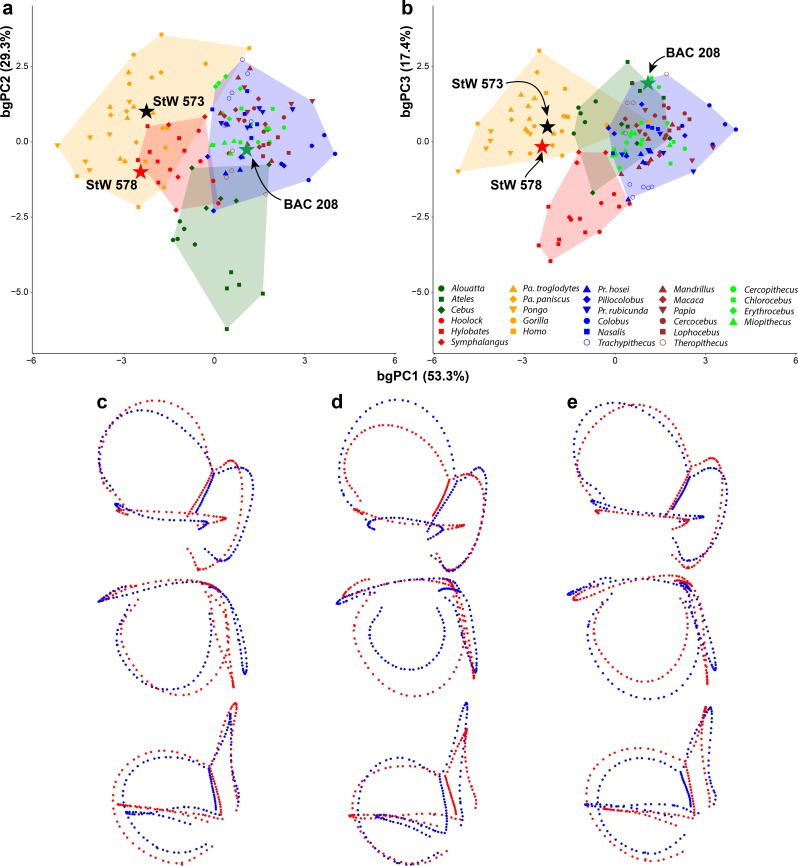
Main patterns of vestibular shape variation among the analyzed anthropoid sample as shown by bivariate plots of principal components from the landmark-based between-group principal components analysis (bgPCA) using major taxa as in Figure 2.(a) bgPC2 vs. bgPC1. (b) bgPC3 vs. bgPC1. Variance explained by each bgPC is included within parentheses. Lateral (top), superior (middle), and anterior (bottom) views of landmarks and semilandmark maximum (red) and minimum (blue) conformations for (c) bgPC1, (d) bgPC2, and (e) bgPC3. Color code as in Figure 2. Hominoids and cercopithecoids are distinguished along bgPC1 (mostly negative vs. positive values, respectively), which is mainly driven by the vertical compression of the anterior SC, as well as the position of the lateral (more anteriorly connecting with the vestibule) and the posterior (displaced posteromedially) canals. bgPC2, driven by the size of the anterior and posterior SCs relative to the lateral one, tends to distinguish platyrrhines (more negative values) from catarrhines, while bgPC3, driven by the size of the anterior and lateral SCs relative to that of the posterior canal, as well as by the relative orientation among the canals, tends to distinguish most hylobatids (more negative values) from great apes, humans, and cercopithecoids (more positive values). The two Australopithecus specimens fall within the hominid range, flanking that of hylobatids. Similarly to the deformation-based approach, StW 578 is more similar to humans (matching the distribution of Homo), while StW 573 is found within the scatter of points of Pan species. In the landmark-based analysis, Oreopithecus overlaps within cercopithecoids and also falls close to platyrrhines.Figure 9—source data 1.Individual scores for all the principal components (bgPC) yielded by the between-group principal components analysis (bgPCA) of landmark-based 3DGM of vestibular shape for anthropoids, using major taxa (i.e., hominids, hylobatids, cercopithecoids, and platyrrhines) as grouping factor.The variance explained by each bgPC is reported within parentheses. Table provided as a separate Excel file.